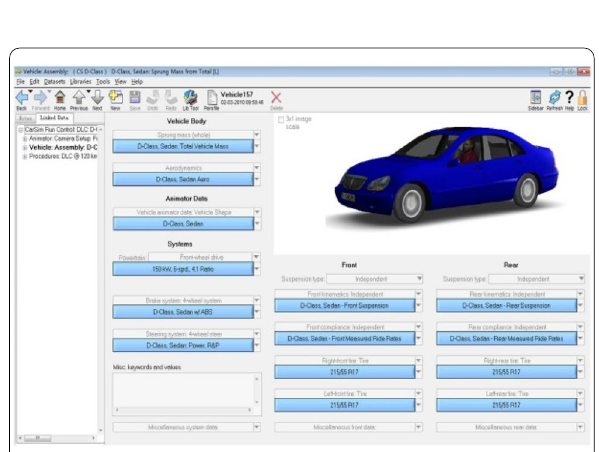
Figure 6 Vehicle